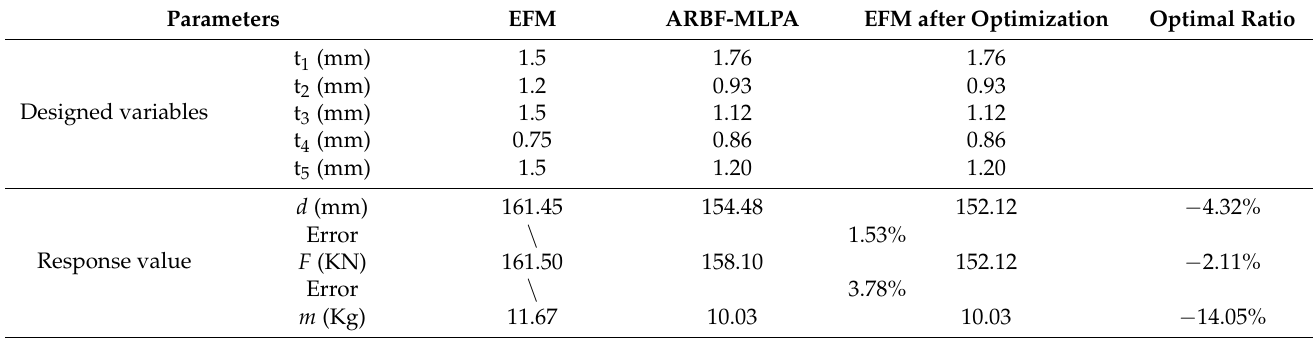
Table 5. Comparison of whole-vehicle crash worthiness before and after